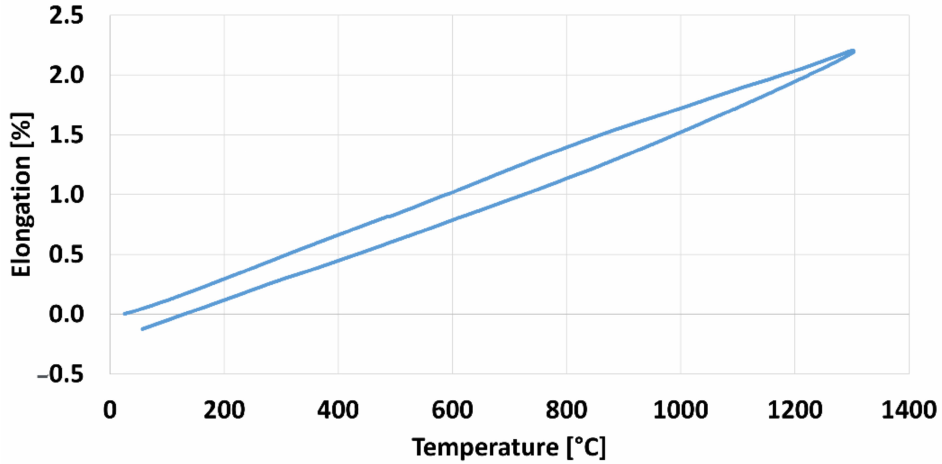
Figure 7. The upper slope was during heating phase and lower slope was during cooling of the sample. The slope for both phase remains same and no sudden shift due to phase transformation was recorded.